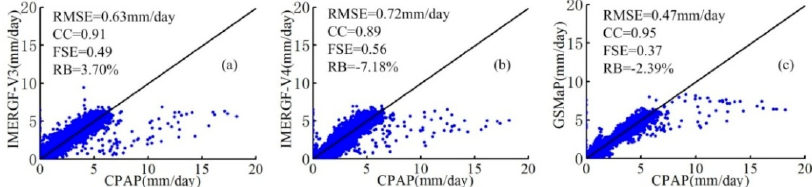
Figure 3. ( a ) represents the RMSE, CC, FSE and RB between annual daily average IMERGF-V3 and CPAP. ( b ) represents the RMSE, CC, FSE and RB between annual daily average IMERGF-V4 and CPAP. ( c ) represents the RMSE, CC, FSE and RB between annual daily average GSMap and CPAP.